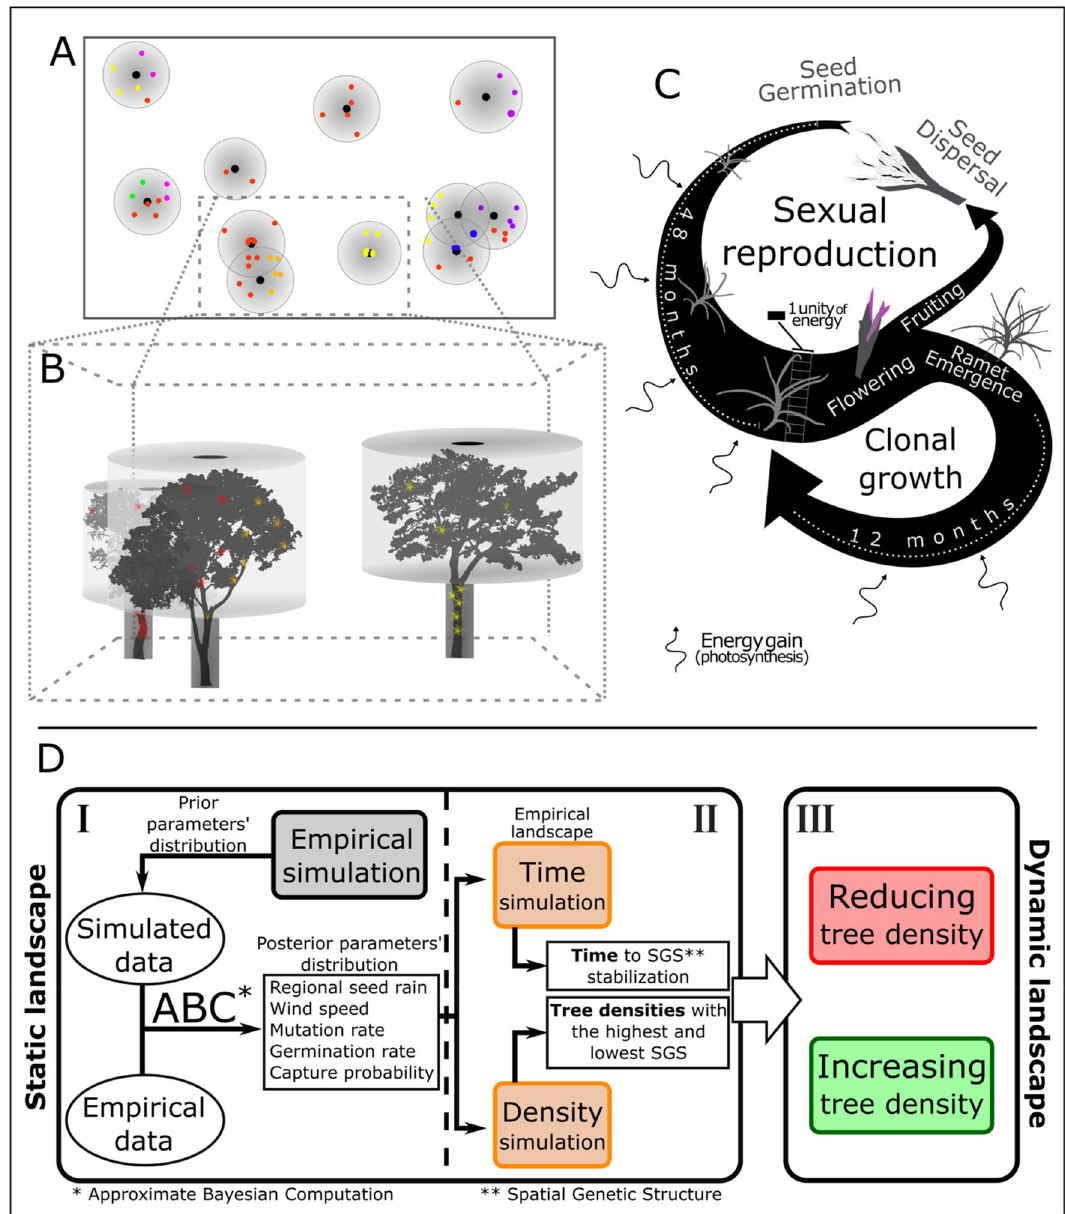
Figure 3. Schematic representations of the TRec model that simulates the Tillandsia recurvata spreading in a 0.40 ha landscape. ( A ) is a landscape representation of the model implemented in NetLogo. Points with distinct colors represent T. recurvata individuals of distinct genetic lineages (MLLs). Larger circles with a gradient gray color and concentric smaller black circles represent the crowns and trunks of distinct trees. ( B ) shows a 3D representation of a cut area of the landscape in ( A ). ( C ) shows a summarized representation the life cycle of T. recurvata . The arrow width represents the amount of energy accumulated in each life stage. Dotted lines indicate the time for maturity and reproduction. Small rectangles indicate the minimal units of energy for individual reproduction. The amount of energy accumulated is variable according to the local shading rate, affecting both sexual reproduction and clonal growth. For the TRec model, the T. recurvata lifespan is 72 months. ( D ) shows a flowchart diagram with the steps to adjust the TRec parameters (in white squares) to run distinct simulations (in colored rounded squares) aiming to analyze the distinct aspects of the effect of tree density on the spatial genetic structure (SGS) of T. recurvata populations. I: delimits the main processes for parameters estimation based on the empirical data; II: delimits the main process for estimation of time for SGS stabilization and tree densities in which the highest and lowest SGS are achieved; III: delimits the main processes to analyze the SGS variation considering dynamic